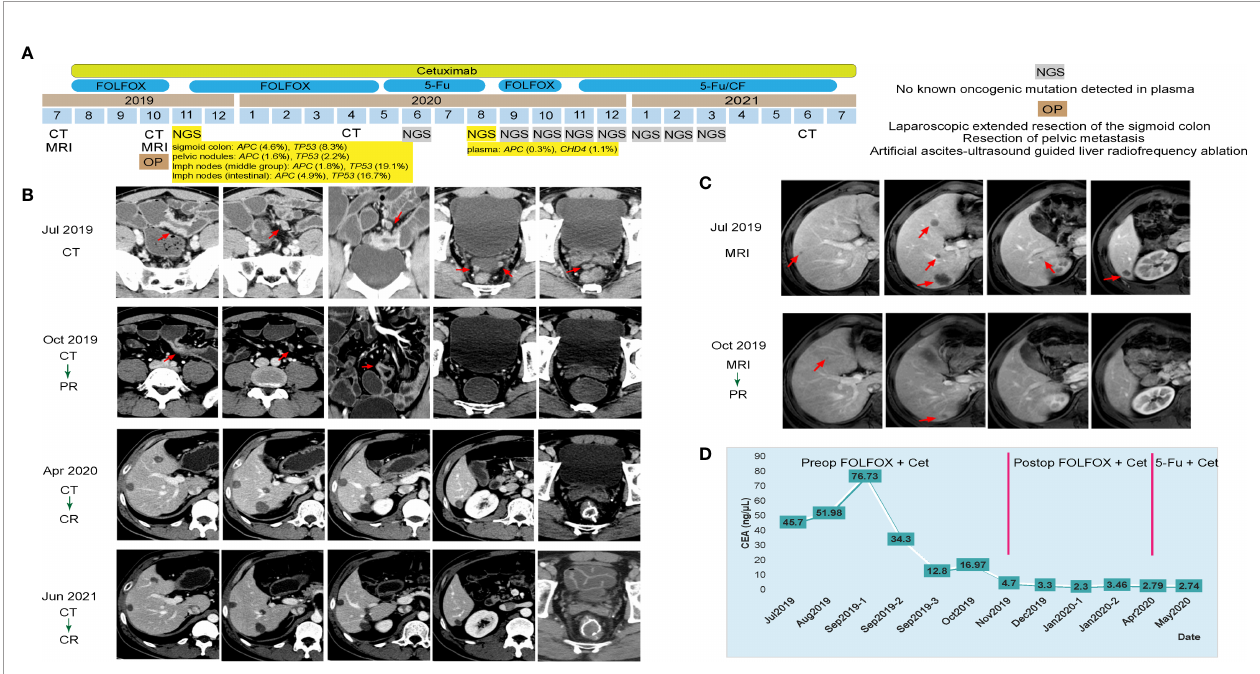
FIGURE 1 | Tumor progression of the patient in case 1. (A) The timeline of diagnosis and treatment. (B) Tumors shrank and disappeared during the course of treatment by computed tomography scans of the patient ’ s abdomen and pelvis; tumors are indicated by red arrows. (C) Tumors shrank and disappeared during the course of treatment by magnetic resonance imaging of the patient ’ s abdomen; tumors are indicated by red arrows. (D) Line chart showing the changes in the levels of carcinoembryonic antigen during the course of